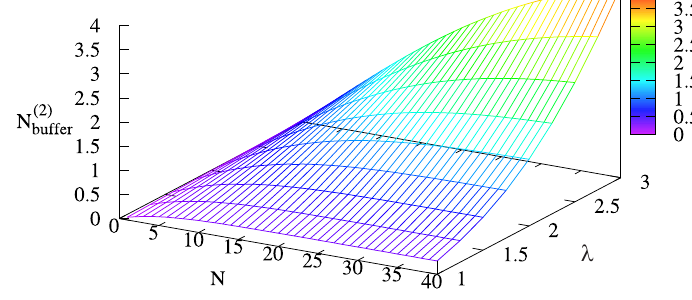
( 2 ) on N and λ . buf fer